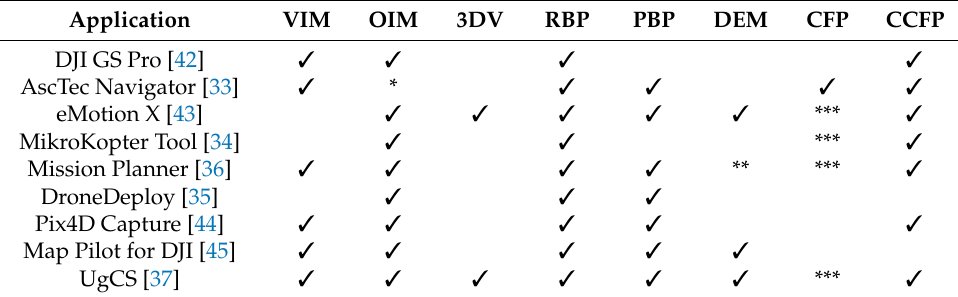
Table 1. Main features of mission planning applications related to the most used